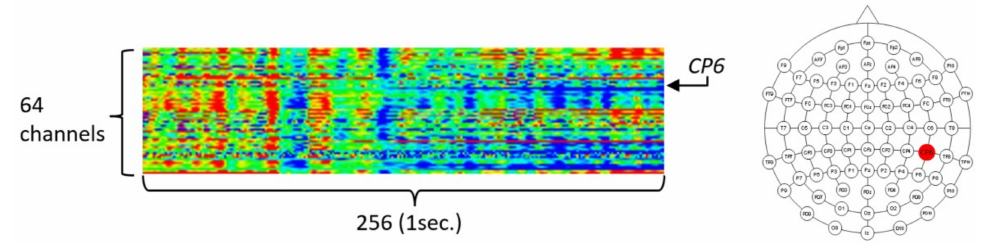
Figure 8. The structure of an instance of University of California Irvine (UCI) EEG data ( left ) and location of the CP6 electrode ( right